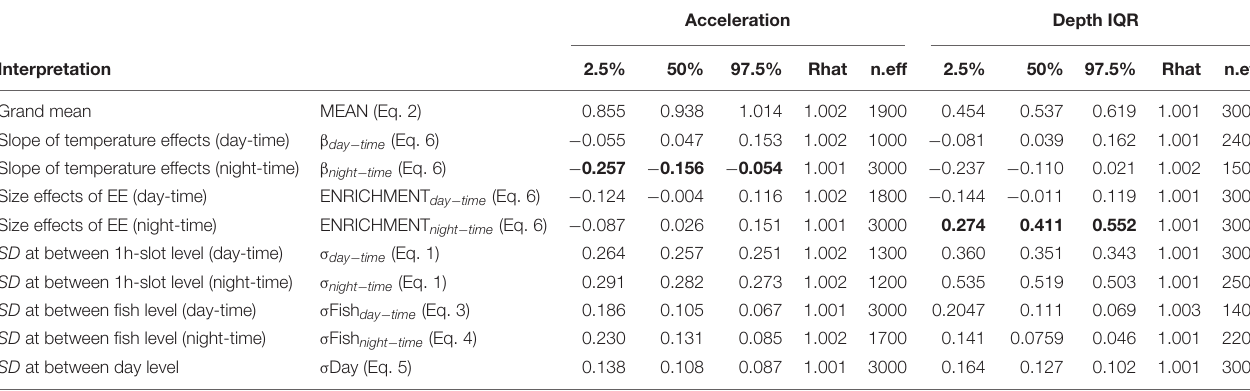
TABLE 1 | Distribution of the main parameters “posteriors” on acceleration and depth interquartile range (IQR): the median (or percentile 50%), 95% confidence interval (percentiles 2.5 and 97.5%), the convergence index of the chains (Rhat) and the number of effective iterations